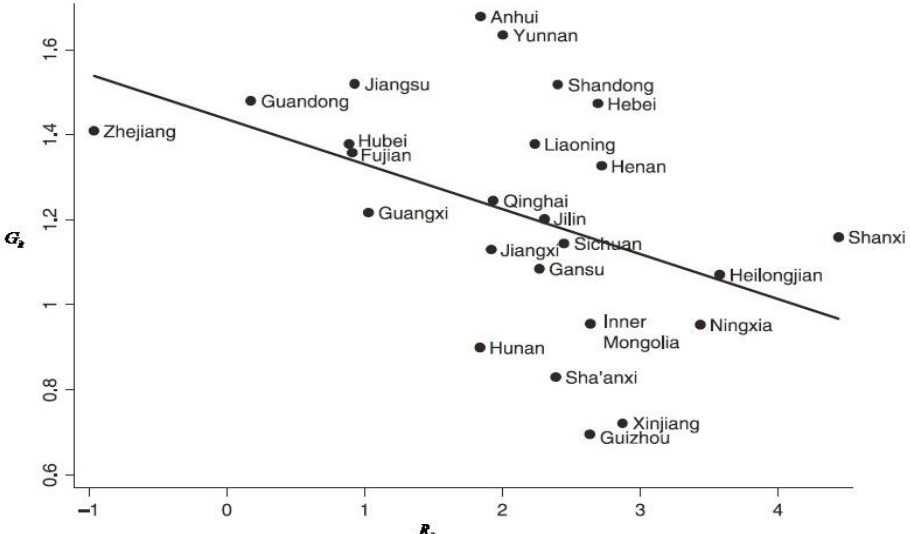
Figure 1. Per capita GDP growth against energy production intensity from 1985 to